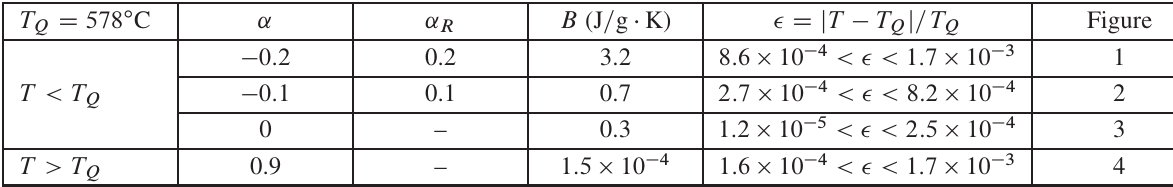
Table 1. Values of the critical exponent ˛ for the specific heat C p and the amplitude B within the temperature interval D 578 ı C) in quartz according to Eq. (1) where the background specific heat was (cid:4) for the ˛ - ˇ phase transition ( T Q taken as A D 1:2 J = g (cid:3) K [2]. The experimental C p data was analyzed for the heating rate 0.069 K = min and cooling rate